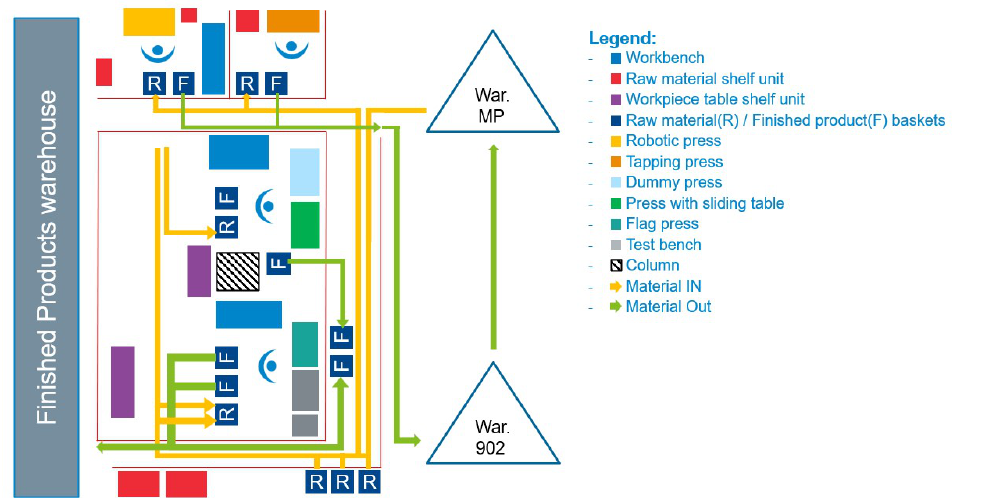
Figure 4. Graphic representation for the layout of stations involved in the project and the relative material